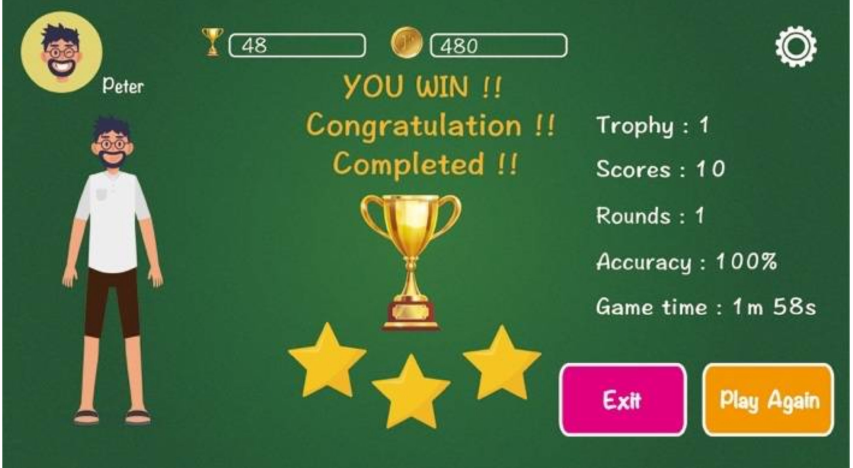
Figure 4. Cleverbrain game design—feedback and reward. After finishing the game, the feedback and rewards of all rounds are shown.